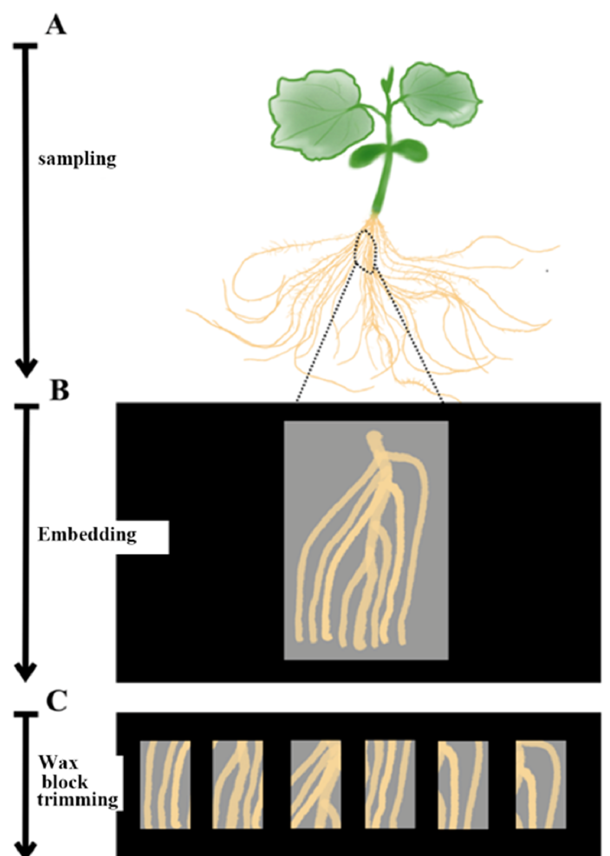
Figure 3. Schematic of the optimized sampling method of cucumber seedling root tissue. Due to the less lignification in stems, the small and softened part of roots of cucumber seedlings ( A ) and the stem with a length of 3–4 cm and the root segments containing lateral roots ( B ) were sampled and then cut into smaller pieces ( C ) before section.